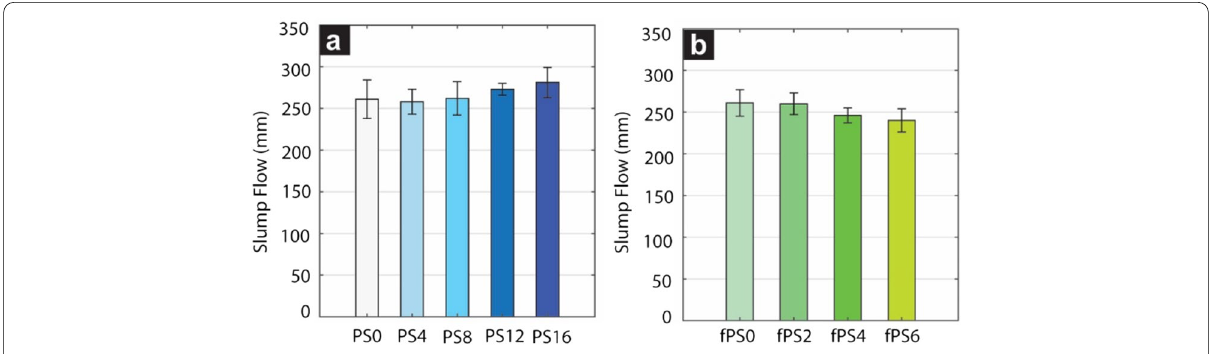
Fig. 5 Slump flow of HFRMC with the a total volume of fibres volume of 1.6%, b PP fibres volume of 1.6%.